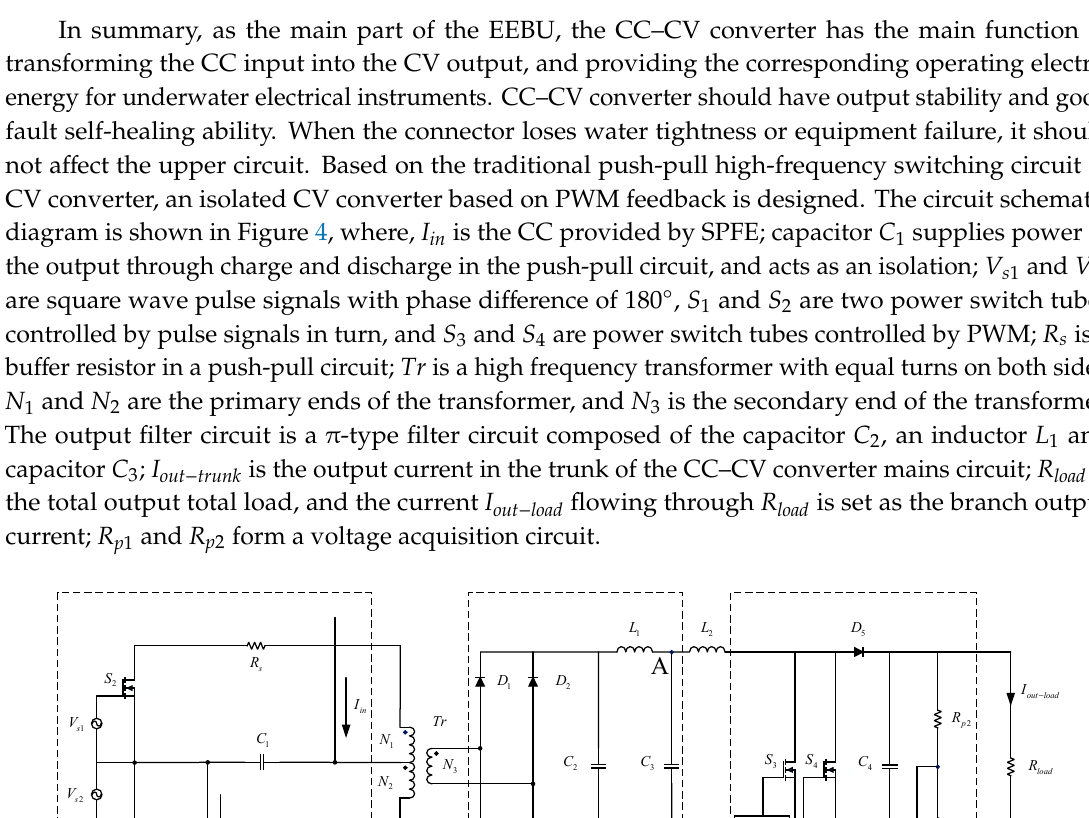
Figure 3. Internal structure diagram of the equipment in secondary nodes (SNs).